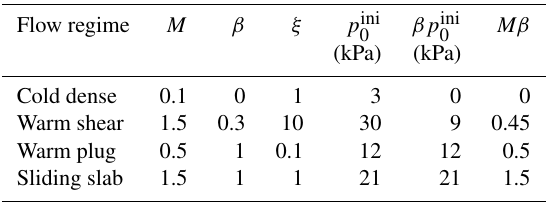
Table 2. Snow properties adopted in the MPM modeling of the flows in the four typical flow